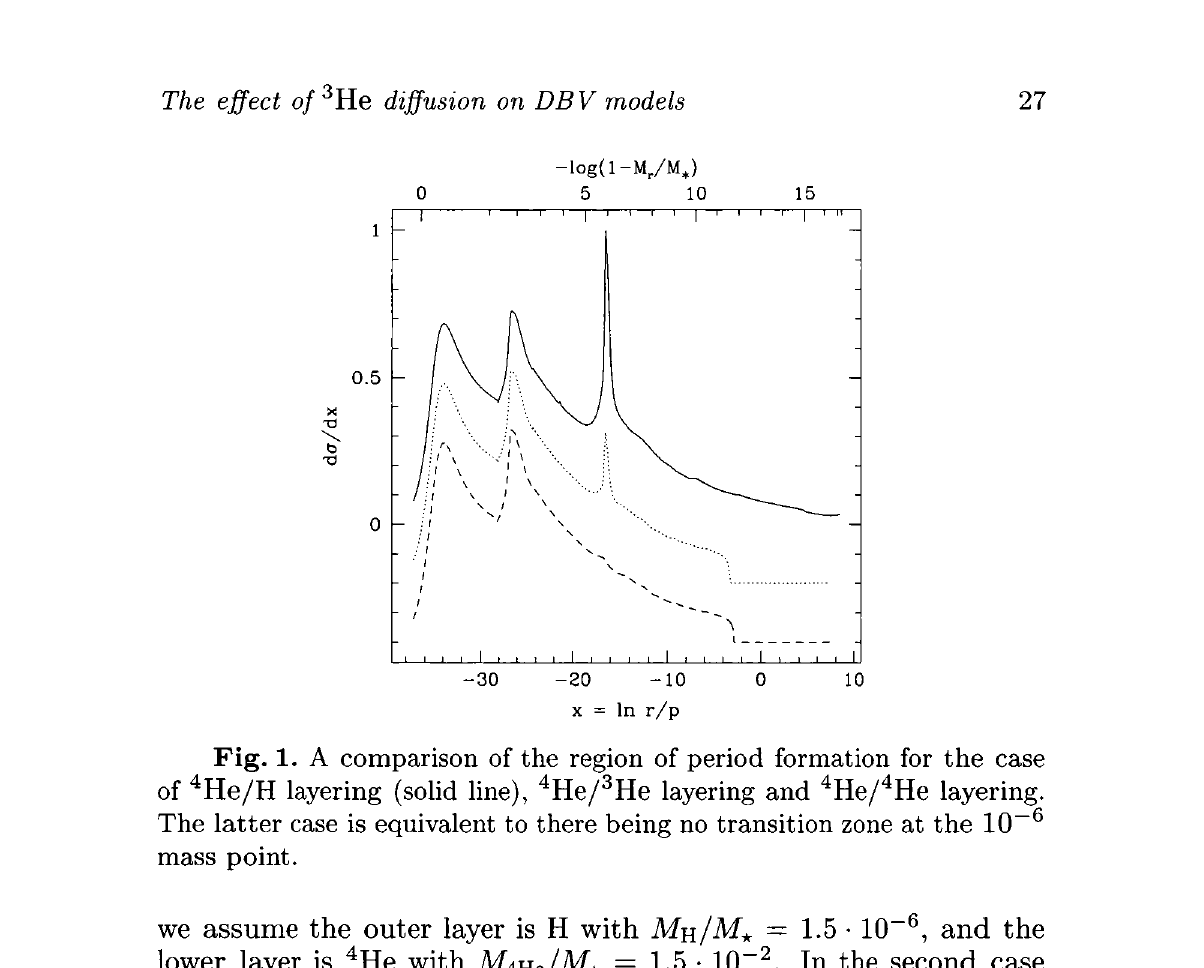
Fig. 1. A comparison of the region of period formation for the case of 4 He/H layering (solid line), 4 He/ 3 He layering and 4 He/ 4 He layering. The latter case is equivalent to there being no transition zone at the 1 0 -6 mass